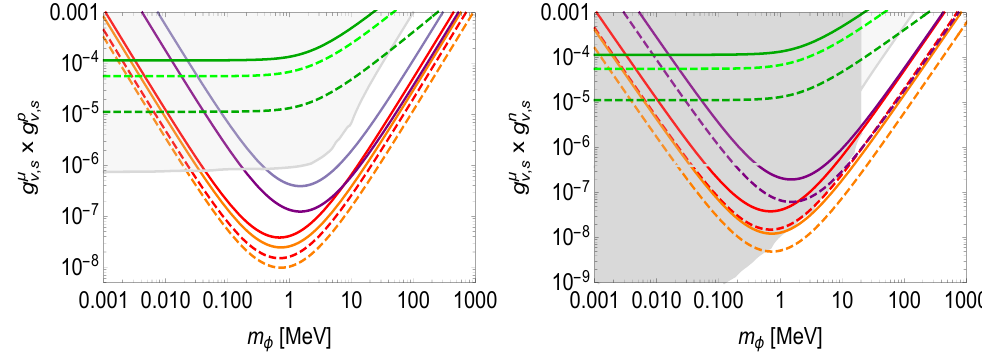
Figure 2 . Left plot: constraints on the dimensionless coupling g µ × g p as a function of the scalar/vector mass m . All the lines correspond to the bounds coming from muonic atoms spec- φ troscopy, see table 1 and table 2 for the experimental and theoretical precision (solid lines existing bounds, dashed future projections). The red/orange/purple curves represent the bound coming from µH / µ D/ µ 4 He Lamb shift measurements respectively. The green curves correspond to the bound coming from HFS measurements and apply only in the case of a vector mediator. The two darker green are the constraints from the 2 s HFS, while the lighter green is the projection for the 1 s HFS considering the projection for the FAMU experiment, see table 2. The light grey region corresponds to the region excluded by the X-ray measurements on the 3 d transitions in − 2 p 5 / 2 3 / 2 muonic 24Mg and 28Si [28]. Right plot: the lines correspond to the same transitions as in the left panel with the difference that we consider here a scenario where the new force couples both with proton and neutrons assuming g p = g n = g N . Hence, the constraint is on g µ × g n where g n indicates the nucleon coupling. The dark grey region corresponds to g µ , where g µ is the bound × g n scattering g 2 g 2 from the muon g − 2 at 10 σ [59]. The neutron coupling g n is constrained by low-energy neutron scattering experiments up to masses ∼ 20 MeV, in the region of interest the strongest bound comes from [60] (see [14] for an overview of these